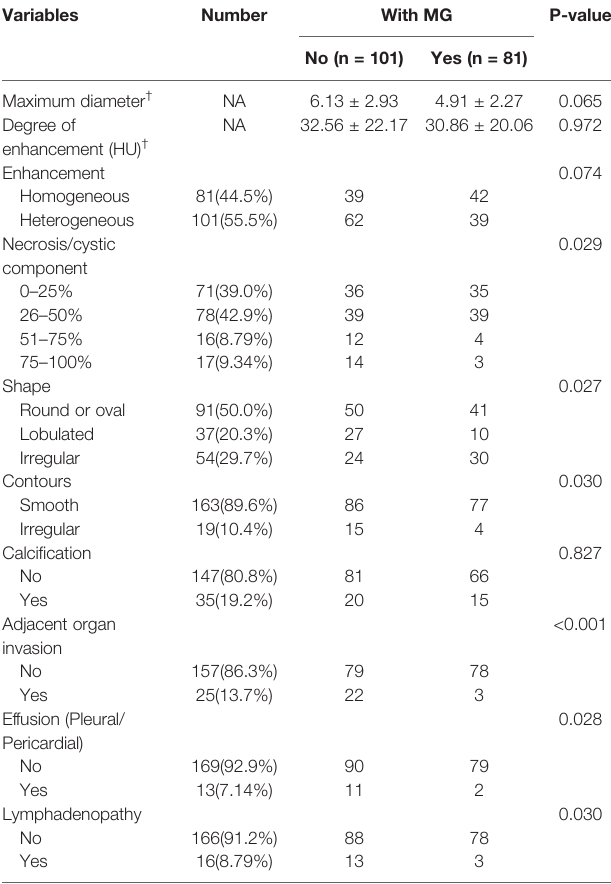
TABLE 2 | Image characteristics of patients with